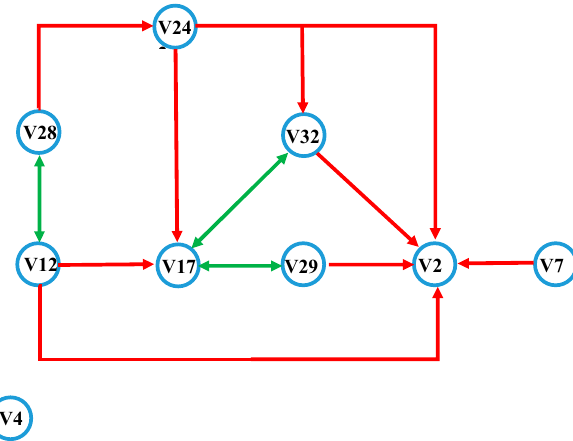
Figure 15. A directed network on the surface of the residual limb. The red line represents the unidirectional flow line, and the green line represents the bidirectional flow line.